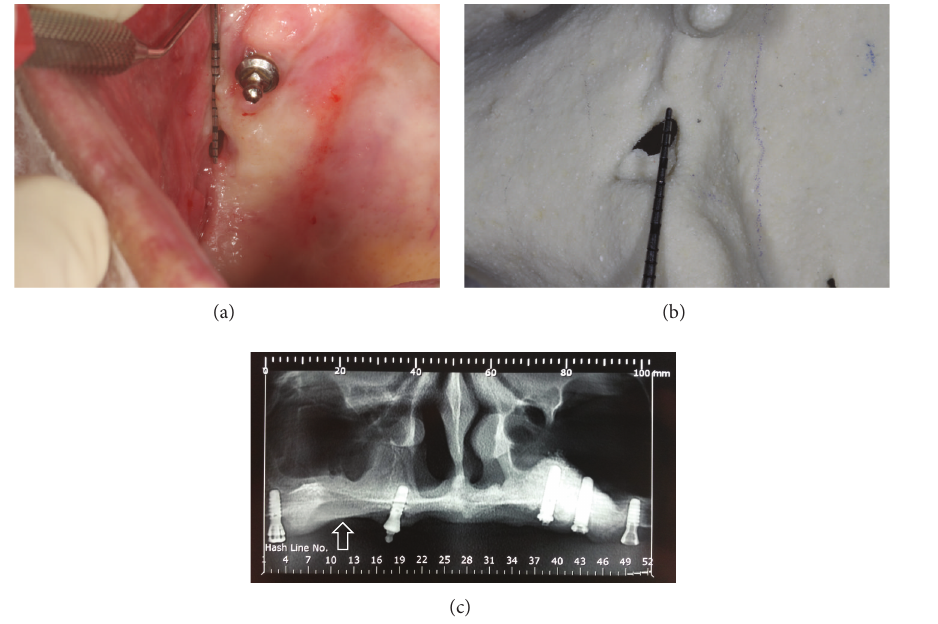
Figure 1: Initial appearance of the patient’s condition upon (a) inspection and (b) prototyping, the arrow indicates an 5 mm opening, and (c) radiographic appearance, the arrow indicates oroantral communication.